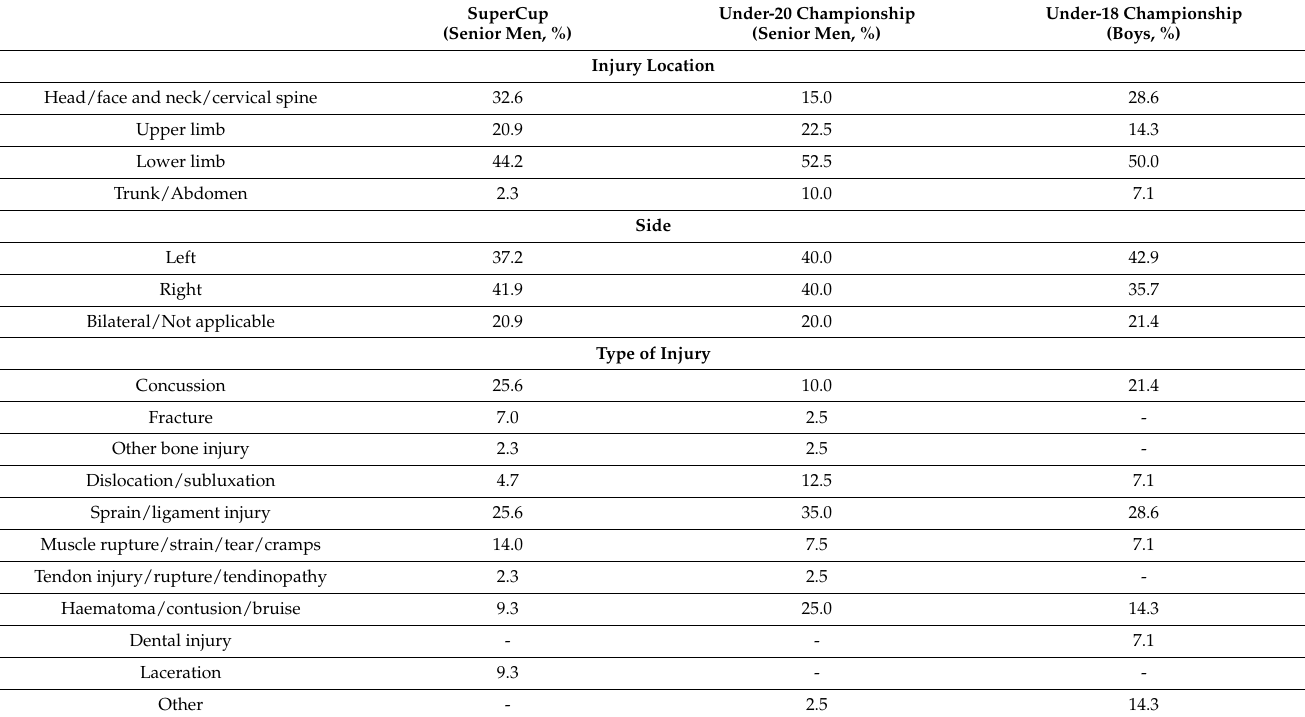
Table 2. Injury location, type, and cause in Rugby Europe